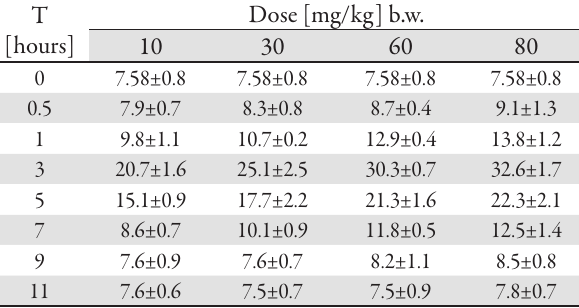
Tab. 1. Plasma renin activity [ng/ml/h] presented as means and standard